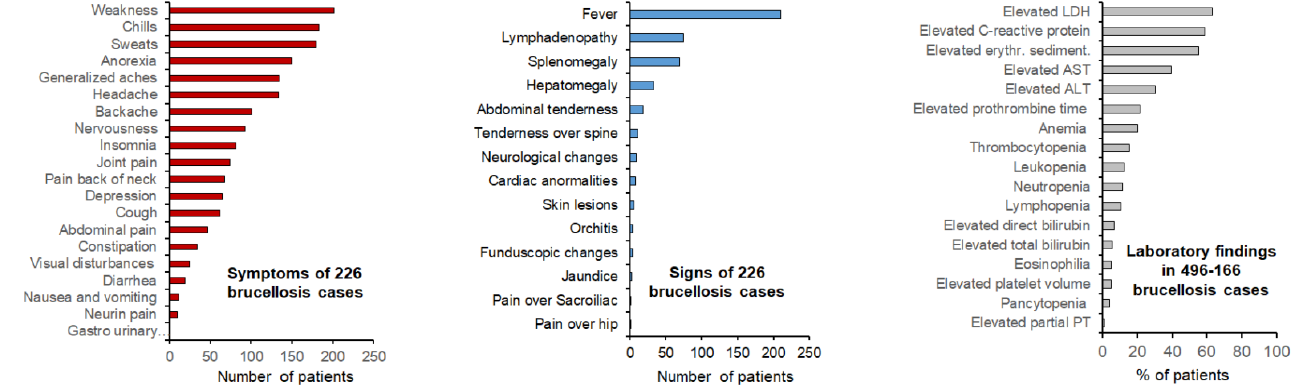
Figure 1. Diversity of clinical symptoms and laboratory findings in human brucellosis. Numbers of symptoms and signs in 250 brucellosis cases (mainly B. abortus infections) from the United States, as reported by Spink [23]. For laboratory findings, the percentages correspond to the total number (between 496 and 166) of patients (mainly B. melitensis infections) examined in a given test , as reported by Parlak et al.